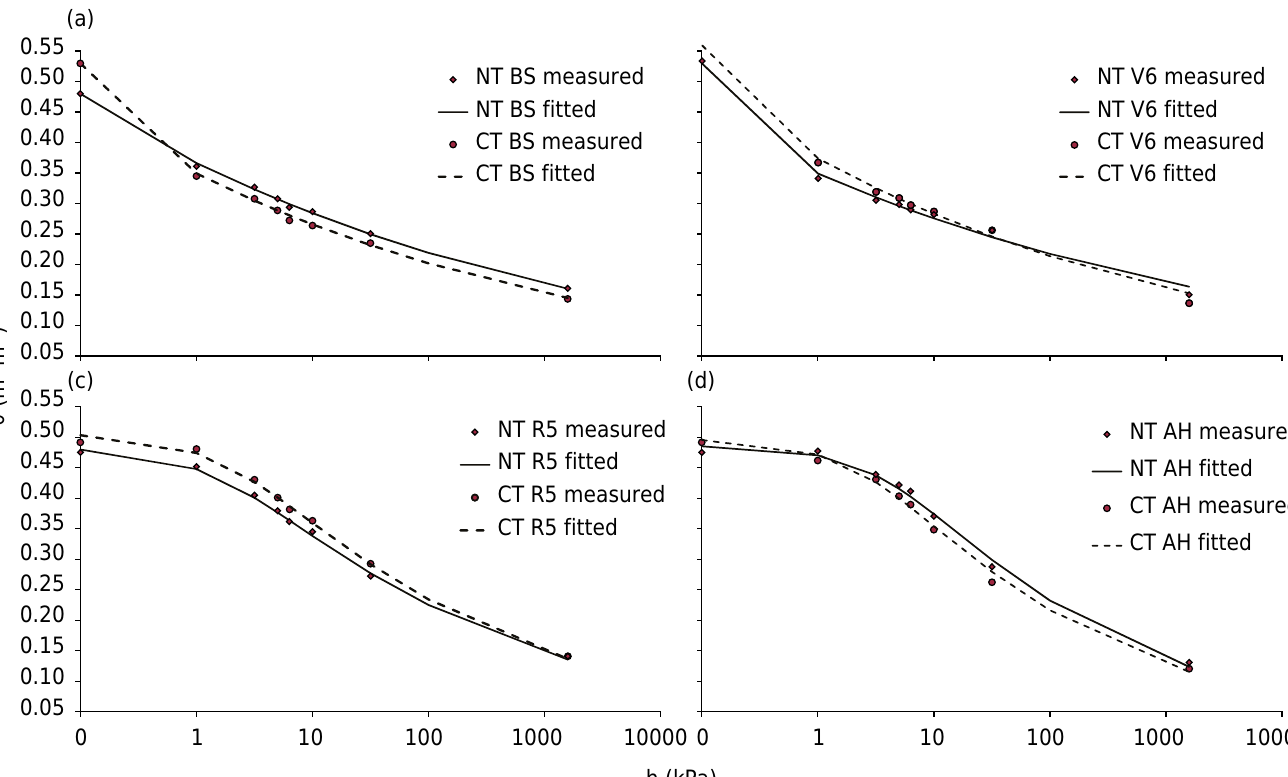
Figure 1. Water retention curves for each treatment and cropping stage of sampling. One representative sample for each treatment and cropping stage of sampling is shown. Lines represent van Genuchten fits (R 2 >0.95), and dots represent measured